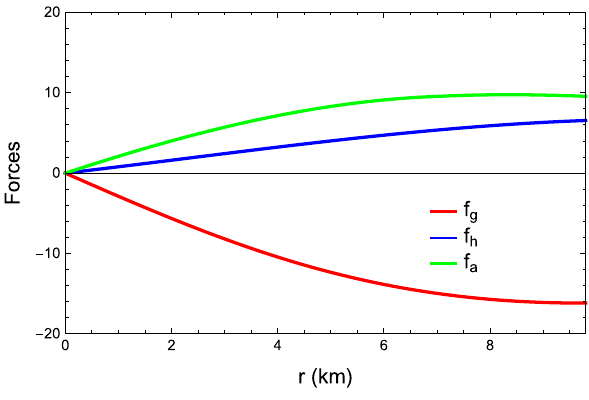
Fig. 7 Static equilibrium under three different forces